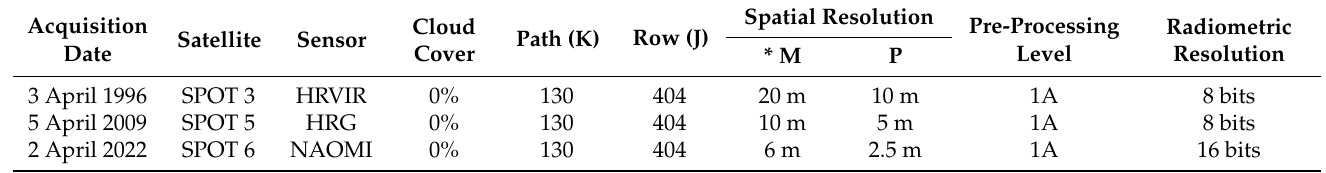
Table 1. List of satellite images collected for the study